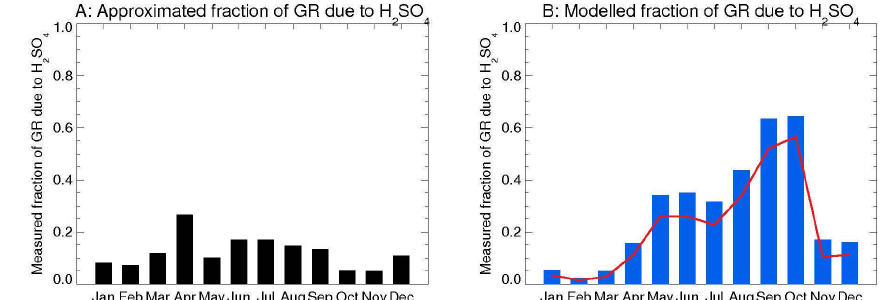
Fig. 7. Approximated fraction of particle growth due to sulphuric acid for observed (left) and simulated (right) results. Red curves as in Fig.